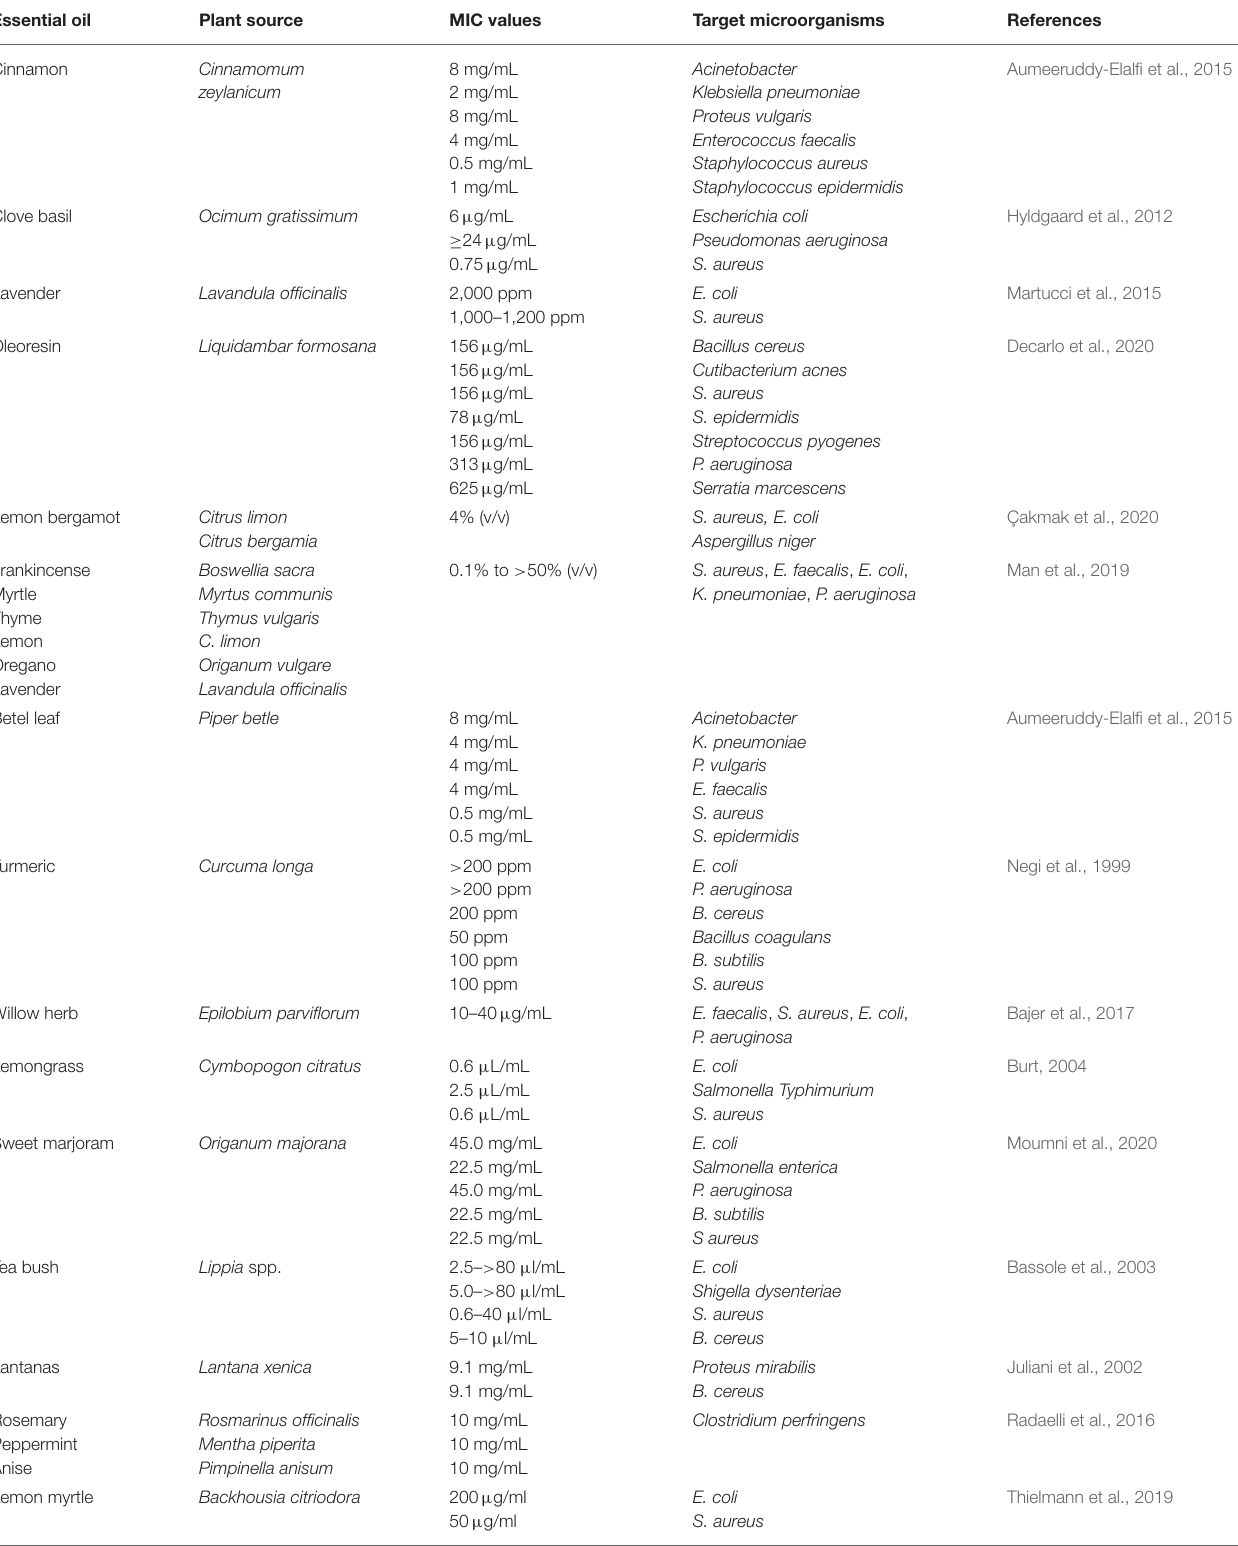
TABLE 2 | Minimum inhibitory concentration (MIC) of essential oils against various microorganisms. Essential